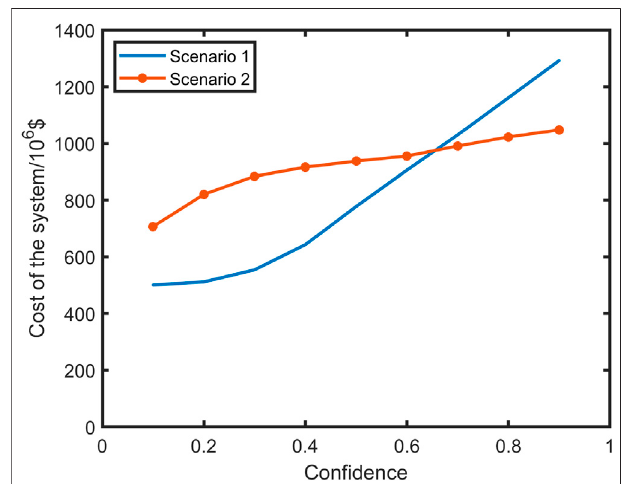
FIGURE 9 | The comparison of total cost changes under different con fi dence levels in two scenarios.